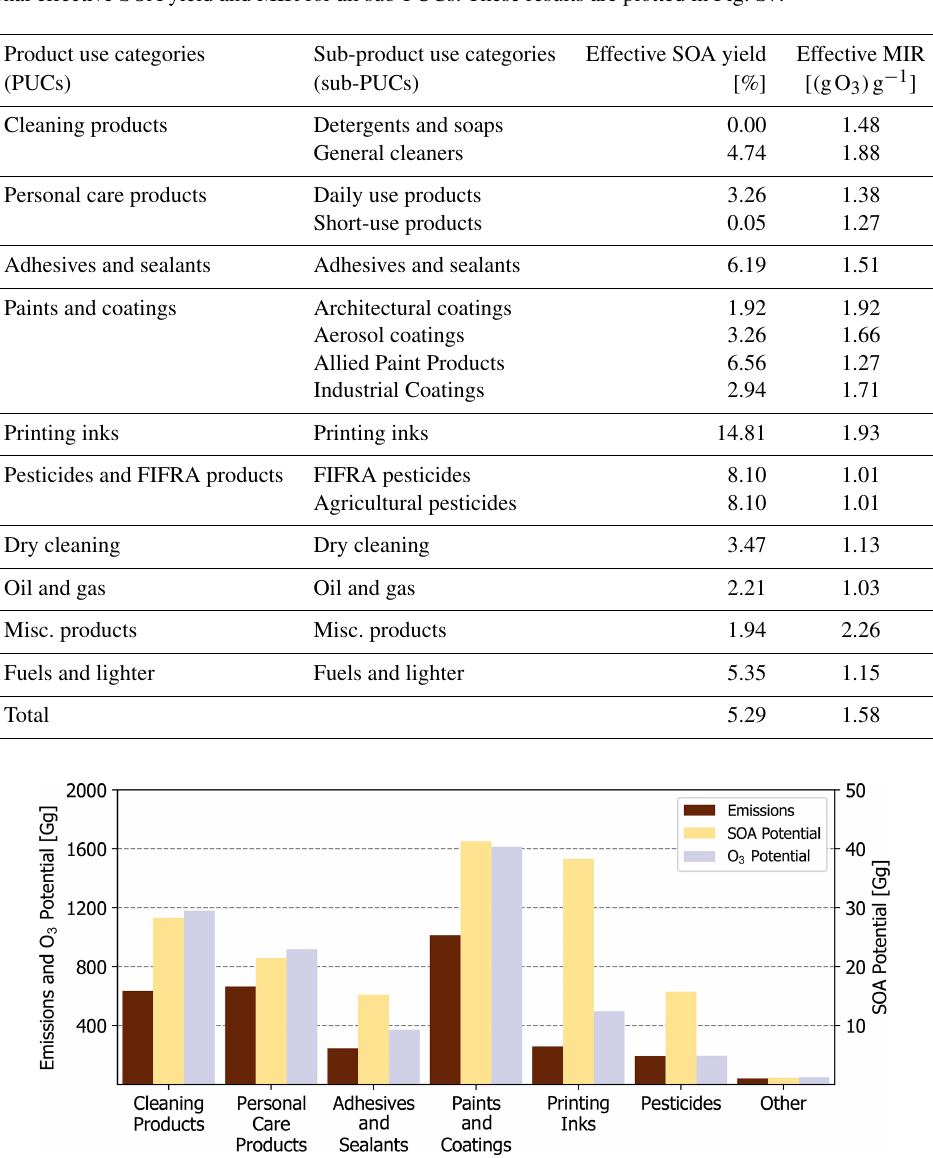
Figure 7. National-level emissions, SOA potential, and O 3 potential by PUC. Other is a summation of dry cleaning, oil and gas, misc. products, and fuels and